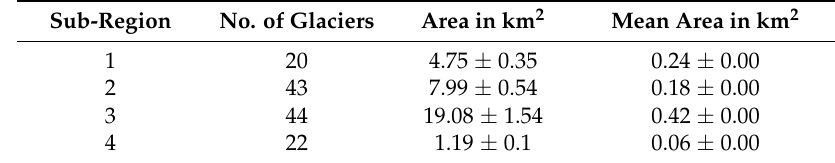
Table 3. Overview of the total number of glaciers in the sub-regions, and the total and mean glacier area in